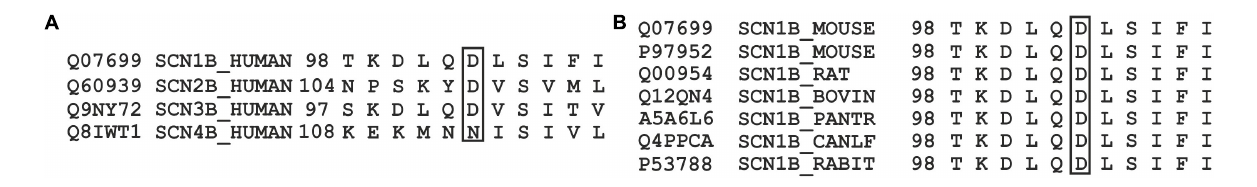
FIGURE 1 | The protein region that includes the mutation is highly conserved. Sequence alignments of the region shared by β 1 and β 1b proteins containing the D103V mutation were performed using Uniprot. The position of the last amino acid of each sequence, and the reference for each protein according to Uniprot are indicated on the left side of each sequence. (A) Sequence alignment of human voltage-gated sodium channel β -subunit family members. (B) Sequence alignment of human voltage-gated sodium channel β 1-subunit of different